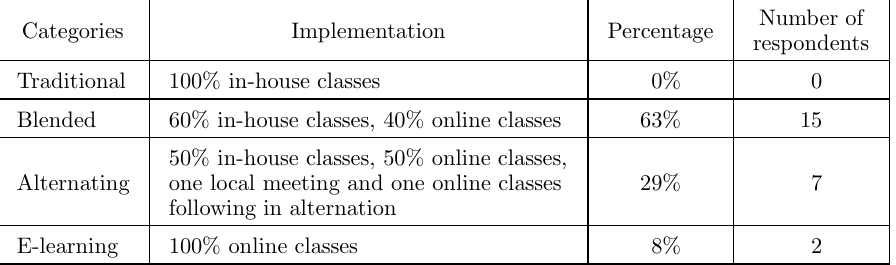
Table 3. Distribution of answers to the question “Which form of biostatistics classes would you